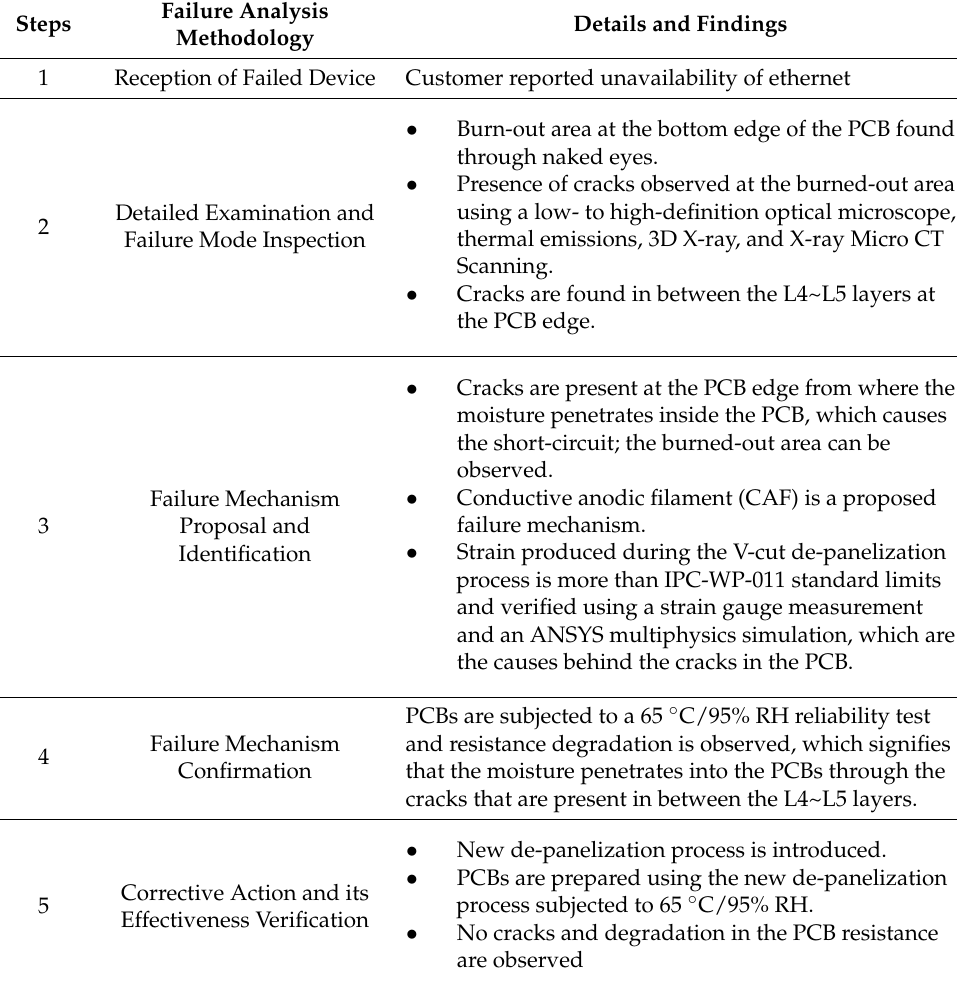
Table 2. Summary of the failure analysis